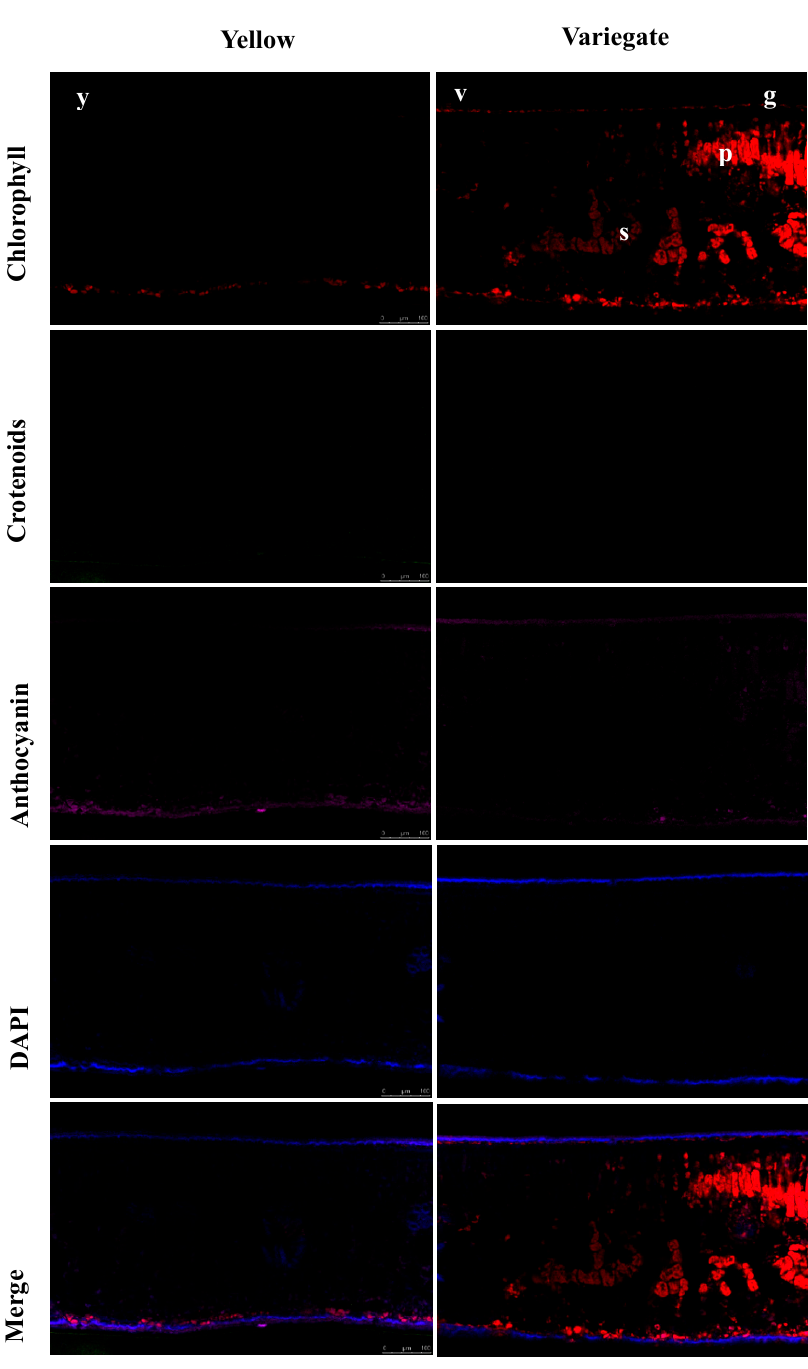
Figure 3. Tissue localization of chlorophyll, carotenoids, and anthocyanins in the leaves analyzed by confocal laser-scanning microscopy. p: palisade parenchyma; s: spongy parenchyma; DAPI: 4 (cid:48) ,6-diamidino-2-phenylindole; DIC: differential interference contrast; y: full-yellow juvenile leaf; v: yellow sectors of variegated leaf; g: green sectors of variegated leaf. Scale bar = 100 µ